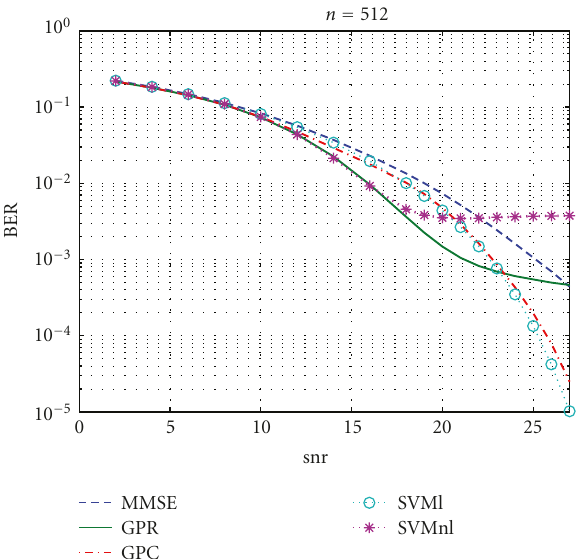
Figure 3: We report the BER versus snr for a multiuser detector with 3 users and a training sequence of 512 symbols. The dashed line represents the linear MMSE receiver, the solid line the GPR, the dash-dotted line the GPC, the dotted line with circles the linear SVM and the dotted line with bullets the nonlinear SVM. The linear SVM is on top of the linear MMSE line.